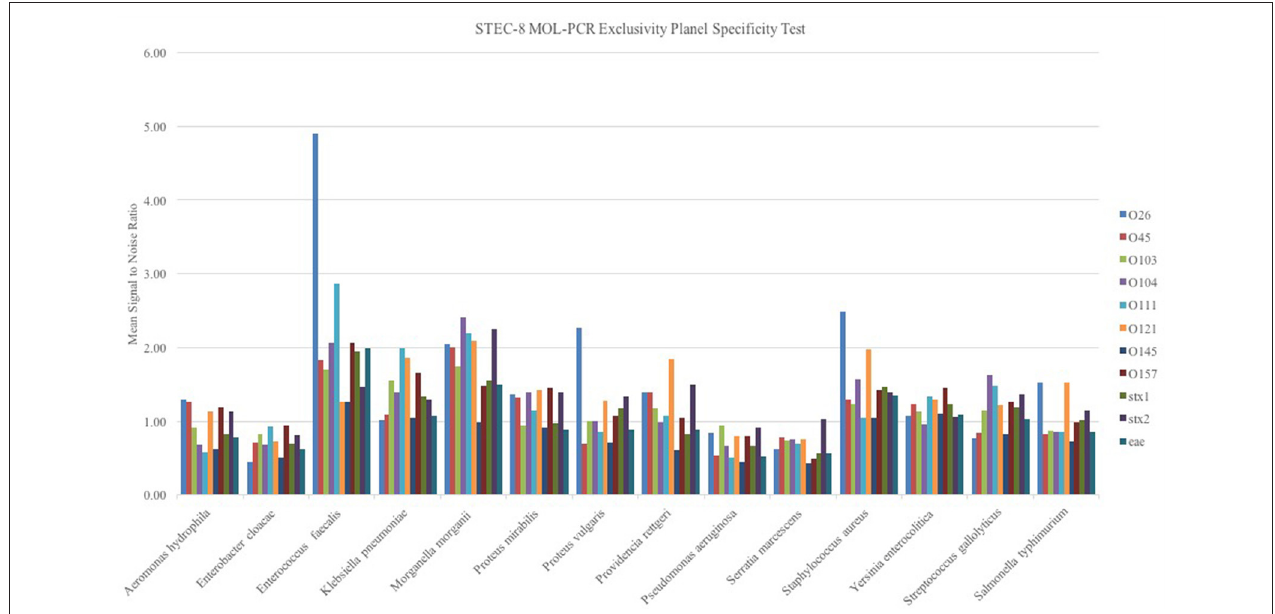
FIGURE 2 | Exclusivity panel of STEC unrelated DNA samples from bacterium as noted in figure evaluated with the STEC-8 MOL-PCR assay. The evaluation 11-plex is color coded on the figure with corresponding signal-to-noise ratio being shown. The majority of the marker responses are below 1.5 signal to